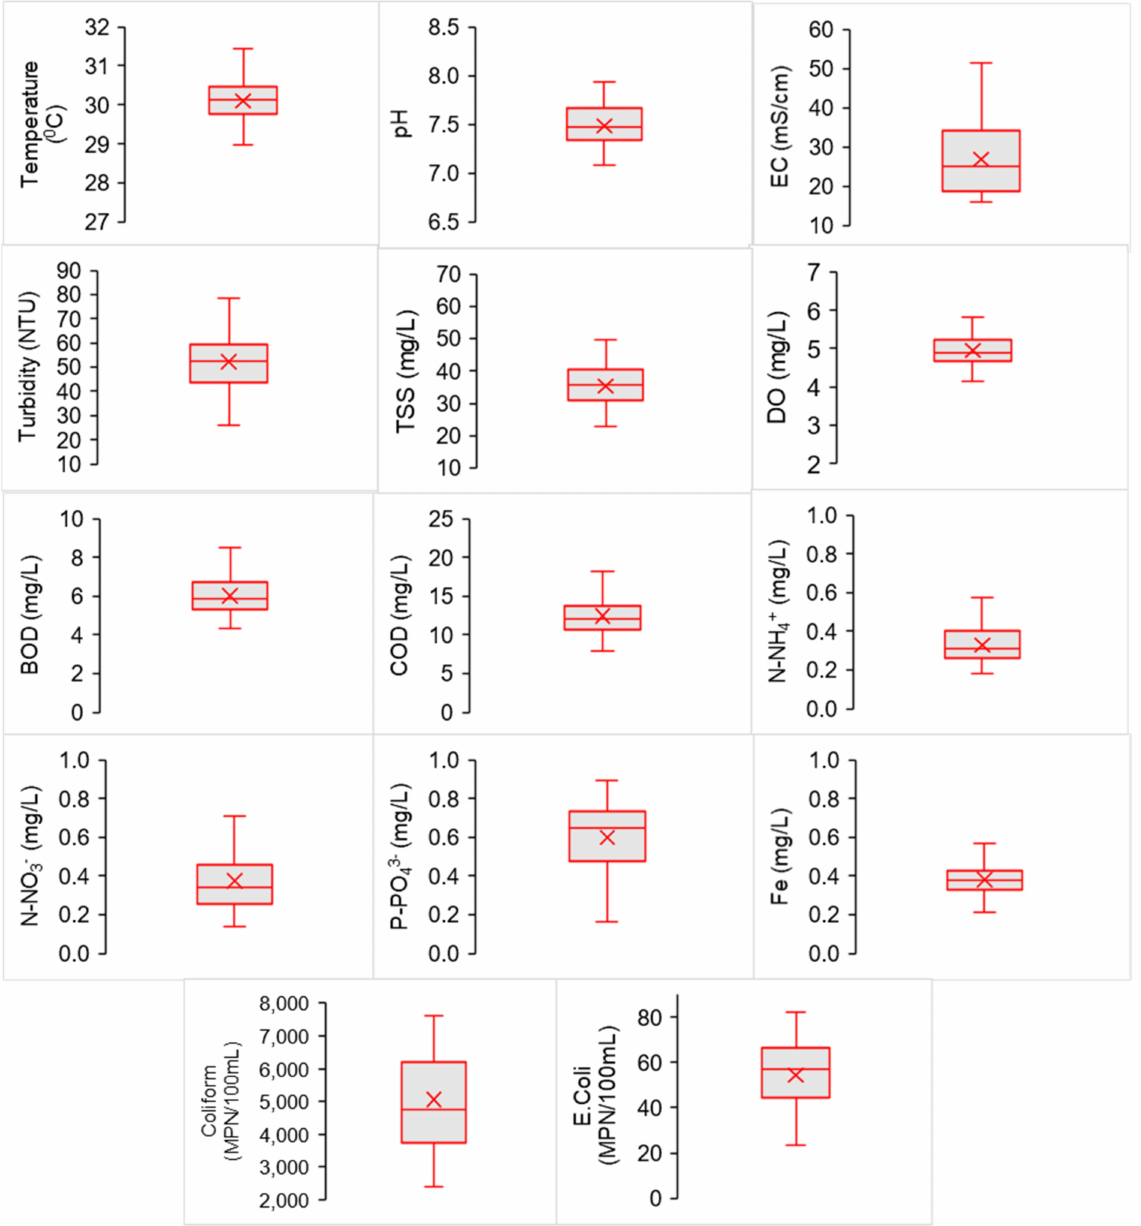
Figure 2. Boxplot of water quality parameters in Vinh Long province. DO concentration fluctuated from 4.14–6.10 mg/L, with an average of 4.98 ± 0.65 mg/L. The findings of DO concentration found at most of the monitoring sites were below the standard ( ≥ 6 mg/L). Only 2 out of 63 positions (S1 and S3) met the standard, accounting for 3.17% of the total. The low DO in the study area was consistent with the high BOD and COD concentrations. The values of BOD and COD ranged from 4.35–8.50 and 7.92–18.20 mg/L, respectively, which also exceeded the standard (4 mg/L-BOD and 10 mg/L-COD). BOD pollution was recorded at all monitoring locations, whereas 87% of the total with COD pollution was